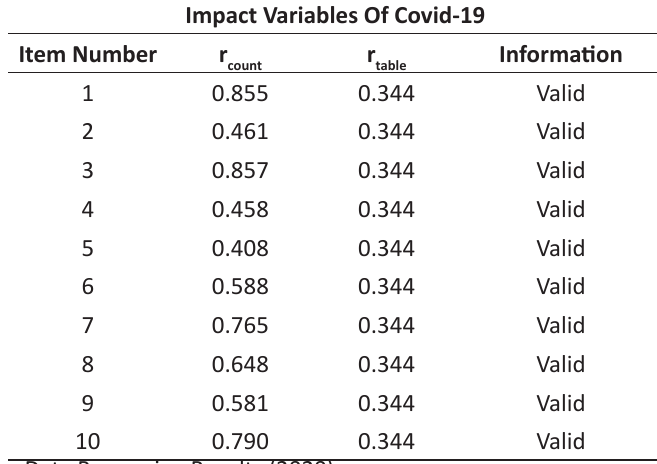
Table 4: Validity Test Results of Covid-19 Impact